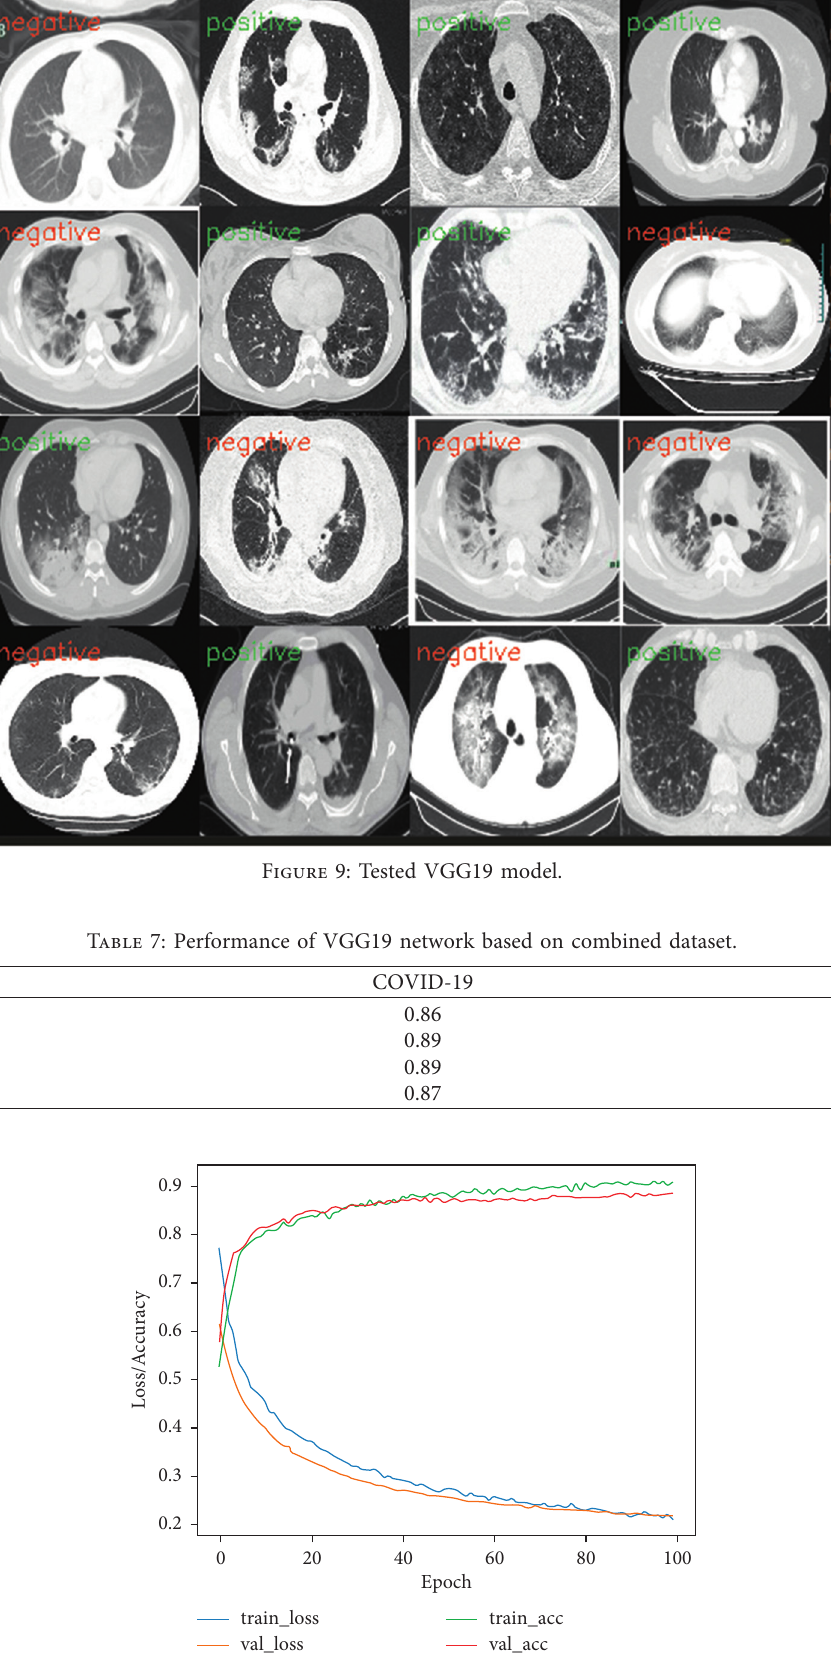
Figure 10: Accuracy and loss for COVID-19